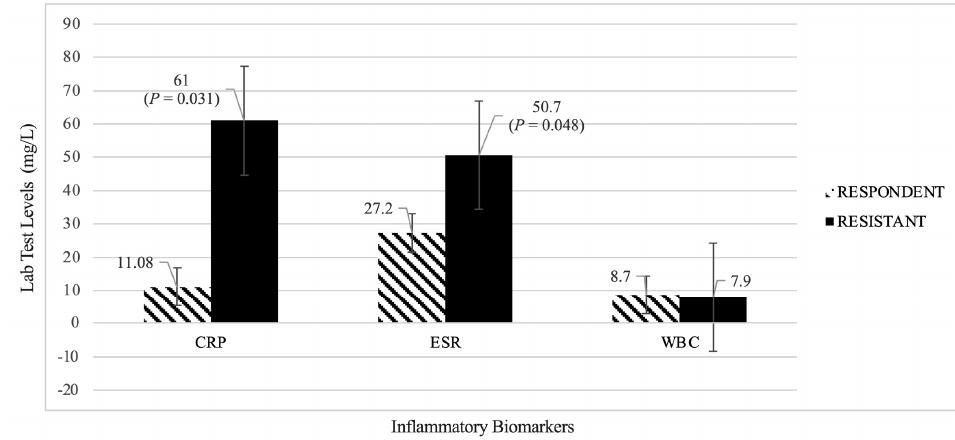
Figure 4. Comparison of the Mean Lab Test Results between the Respondent Group and the Resistant Group. CRP: C-reactive protein; ESR: erythrocyte sedimentation rate; WBC: white blood cells.